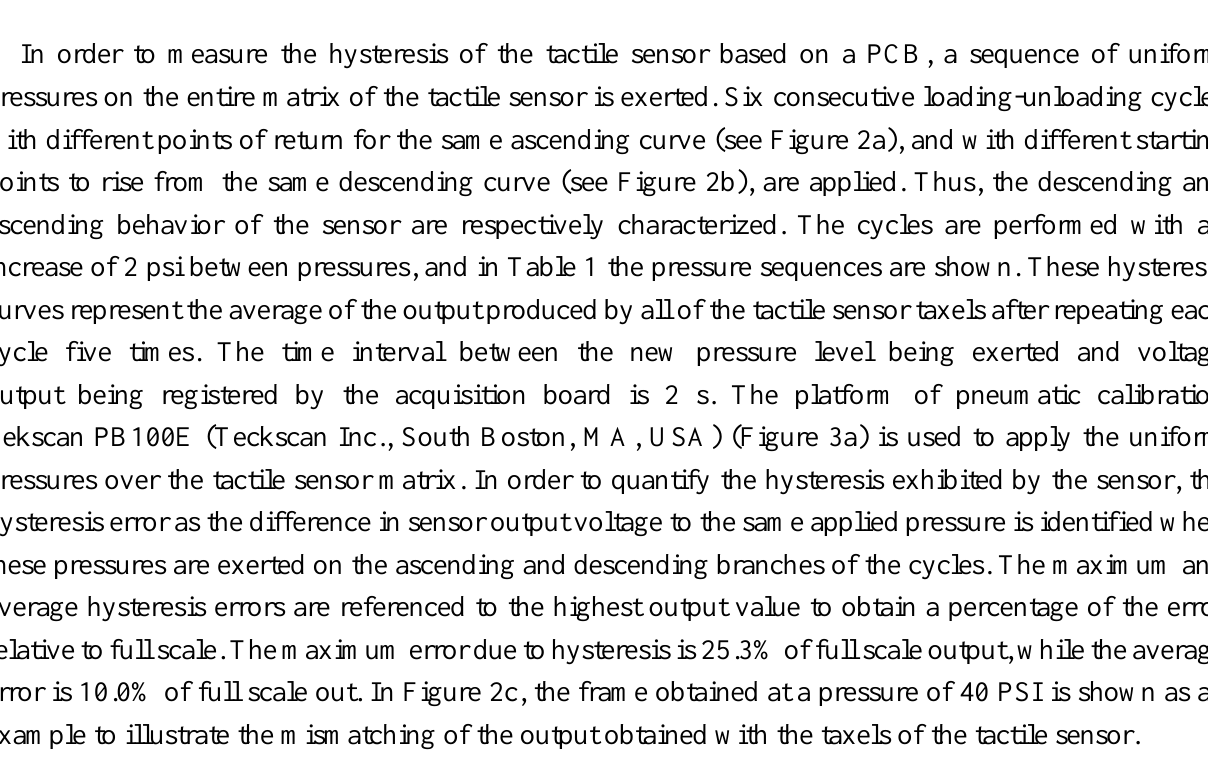
Figure 1. Tactile sensor based on a flexible printed circuit